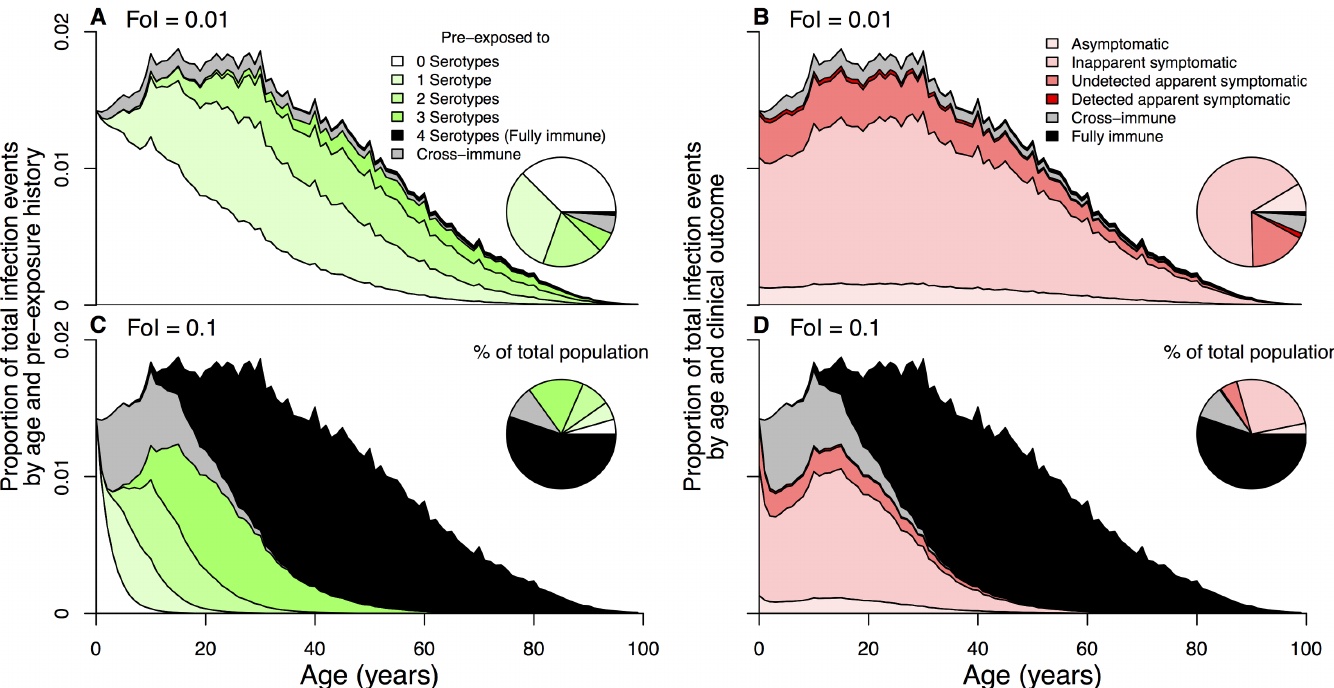
Fig 4. Pre-exposure history (A and C) and infection class (B and D) stratification by age and for FoI values of 0.01 (top) and 0.1 (bottom). An individuals’ susceptibility to infection and clinical outcome depend on pre-exposure history. Serohistory by age (A and C) is estimated using a system of ordinary differential equations with state variables denoting the proportion of the population pre-exposed to 0–4 serotypes. Transition to pre-exposure state i occurs at rate i FoI. Individuals entering a new pre-exposure state have temporary heterologous immunity (gray) to all serotypes before later becoming susceptible again to each serotype to which they do not have a history of exposure. After four infections with four different serotypes, individuals are assumed fully immune (black) to all serotypes.